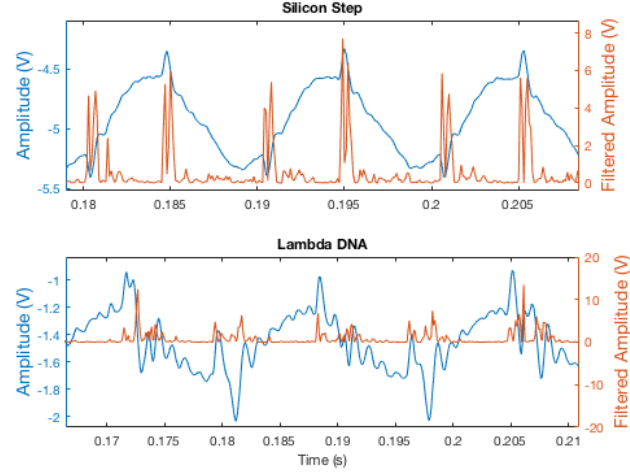
Figure 9. Amplitude signal during tracking of small features, pre- (sinusoidal, blue) and post-filtering (sinusoid removed, orange). Note that the sharp edges of the Si steps ( top plot) yields sharp edges in the filtered signal, while the rounded edges of the λ -DNA ( bottom plot) lead to a much smaller and noisier edge